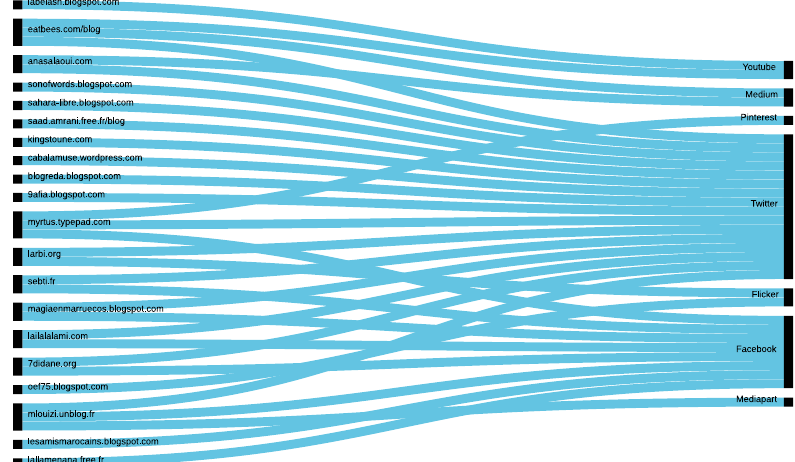
Fig. 3 From blogs to social media. A list of the blogs alive in 2008 facing their respective social network accounts in 2018.